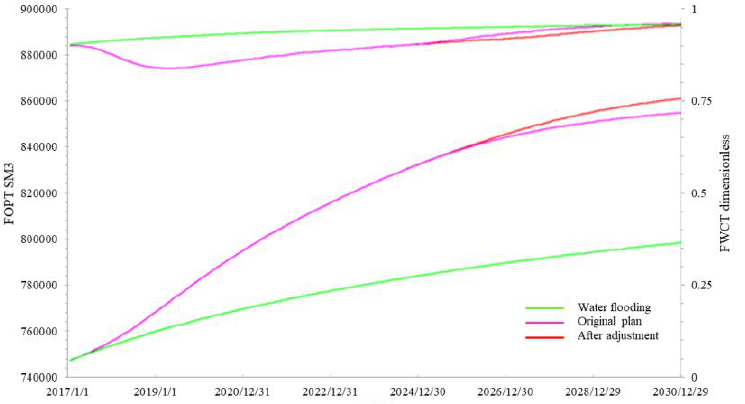
Figure 12—Comparison of recovery efficiency before and after optimization using numerical